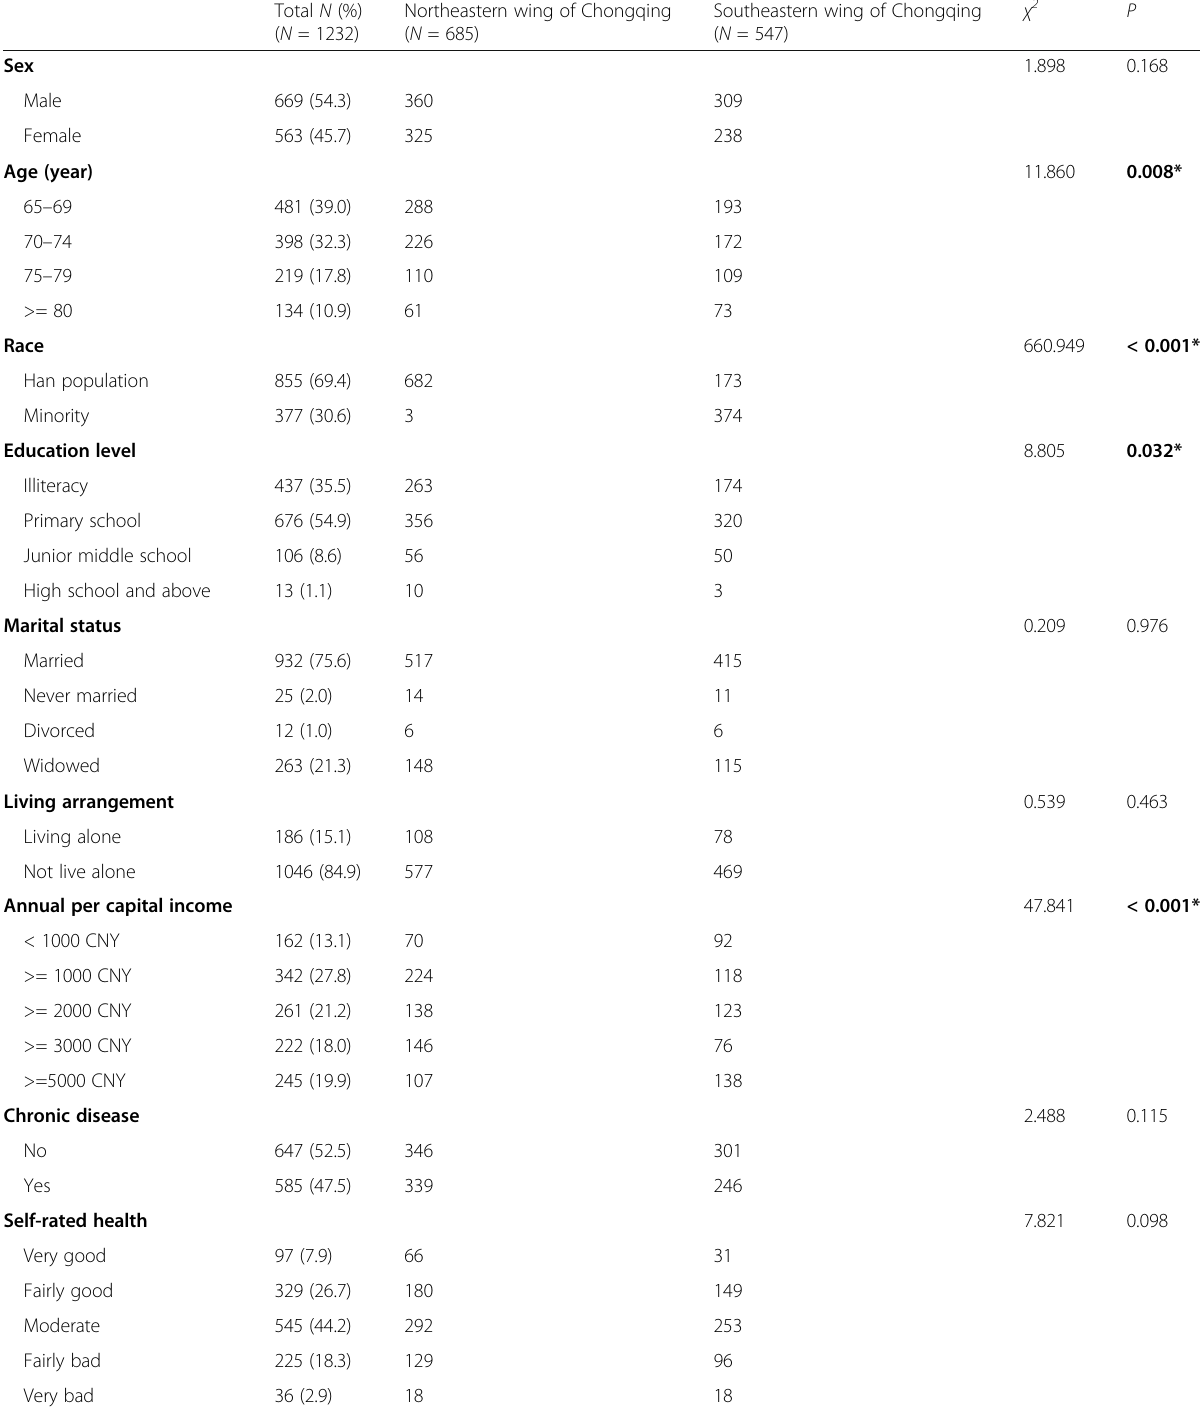
Table 1 Demographic characteristic of the elderly in poverty state counties of Chongqing